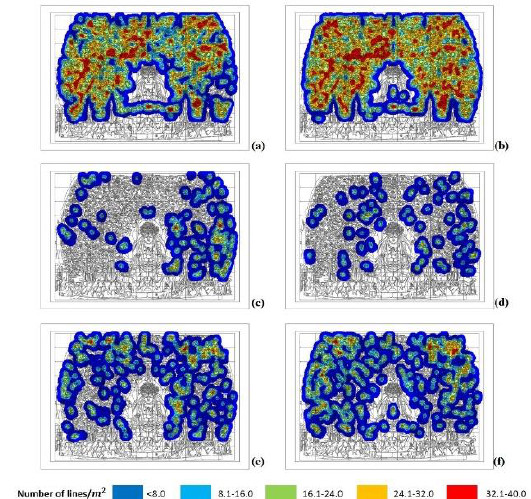
Figure 8 . The outcomes of kernel density analysis which can reflect coupling relation among diseases